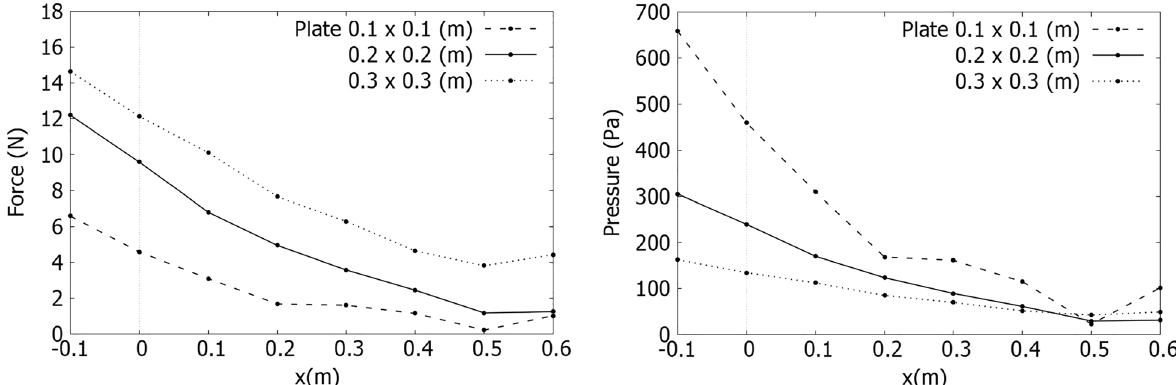
Fig. 6 Experimentally obtained results indicating the measured force and pressure acting on the plates